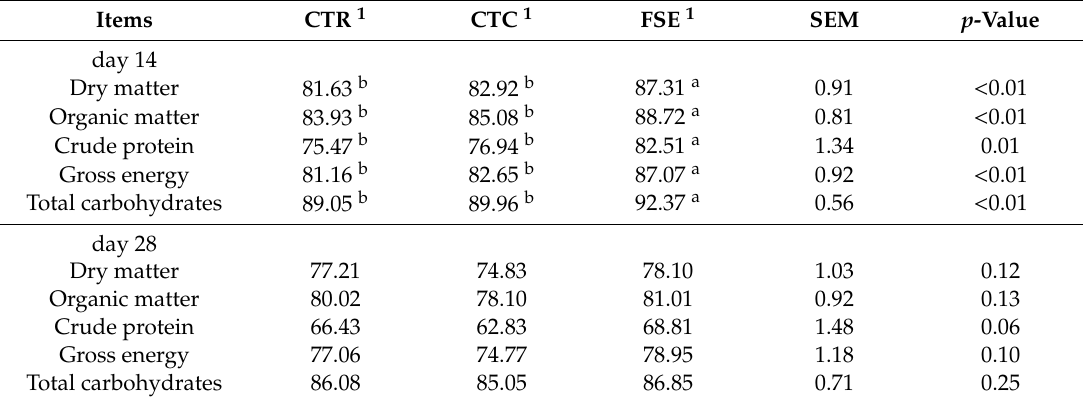
Table 3. E ff ects of Forsythia suspense extract on apparent total tract digestibility of nutrients in weaned piglets